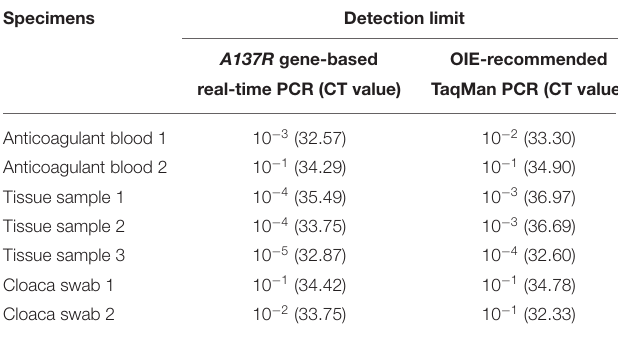
TABLE 3 | Sensitivity of different PCR assays for detection of ASFV.